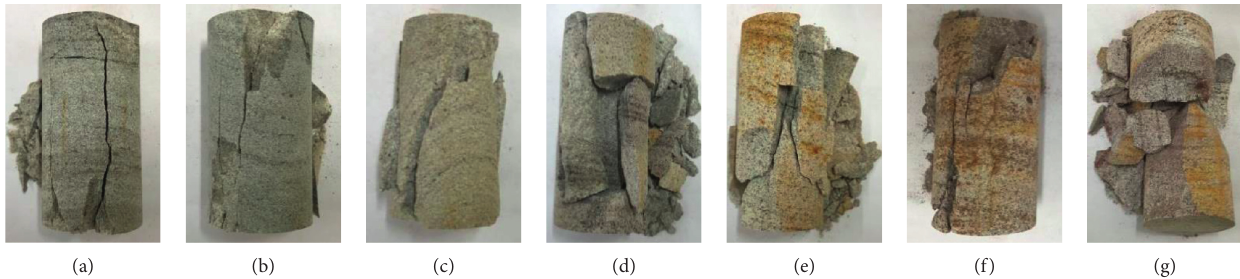
Figure 13: Static failure mode of argillaceous sandstone after high temperature. (a) 20 ° C. (b) 100 ° C. (c) 200 ° C. (d) 400 ° C. (e) 600 ° C (f) 800 ° C. (g) 1000 °